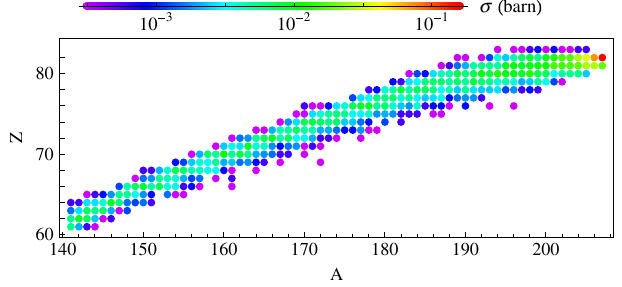
FIG. 1. (Color) The cross sections for creating heavy isotopes 106 : 4 GeV = nuleon 208 Pb 82 þ beam impacting on a carbon target. The cross sections were simulated by FLUKA